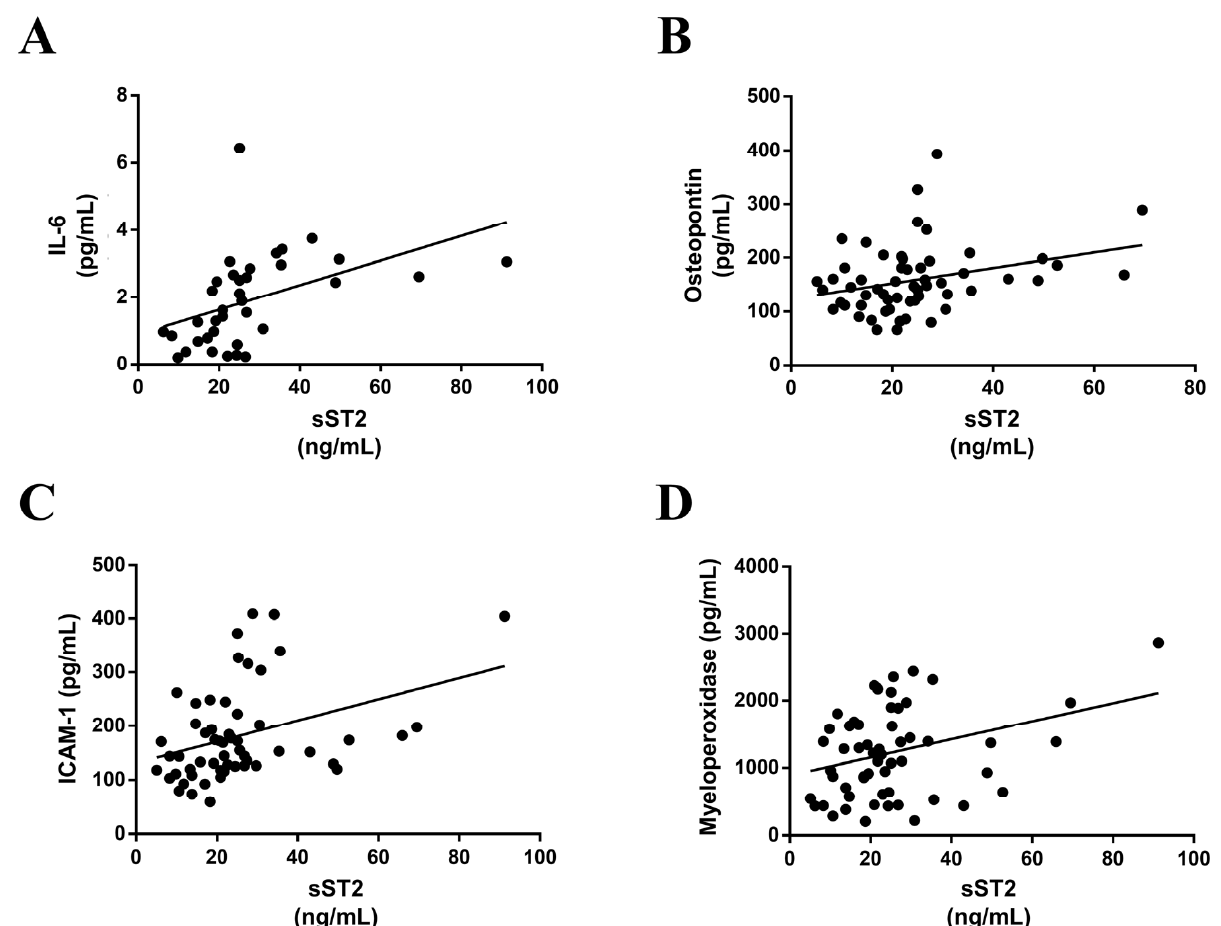
Figure 2. sST2 correlates with inflammatory markers. Serum levels of sST2 positively correlated with serum IL-6 ( A ), osteopontin ( B ), ICAM-1 ( C ) and myeloperoxidase ( D ). IL, interleukin; ICAM, intercellular adhesion molecule.